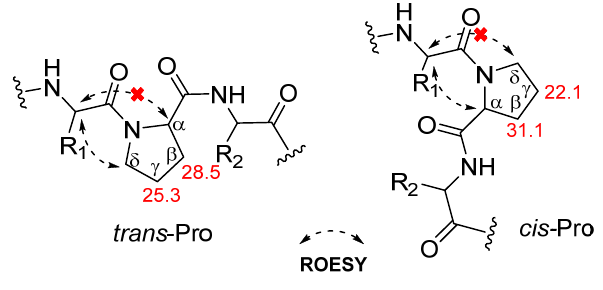
Figure 3. Proline isomerization of 1 .